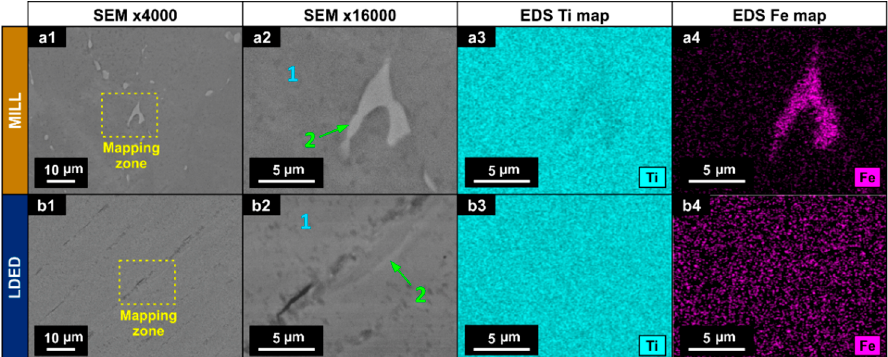
Figure 4. SEM micrographs ( a1 , a2 , b1 , b2 ) and EDS mapping for Ti ( a3 , b3 ) and Fe ( a4 , b4 ) for MILL ( a1–a4 ) and LDED ( b1–b4 ) materials. Table 2. Chemical composition (wt %) of the matrix (1) and segregation zone (2) determined by semi-quantitative EDS